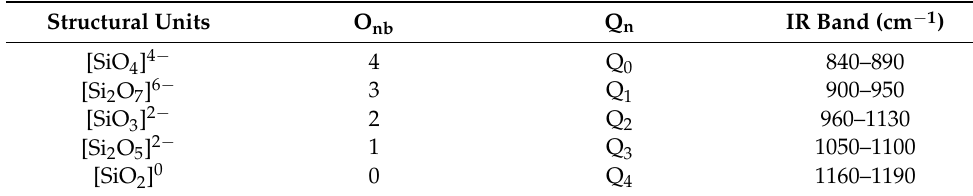
Table 3. Attribution of the Q n -species structure unit in infrared spectra. Structural Units